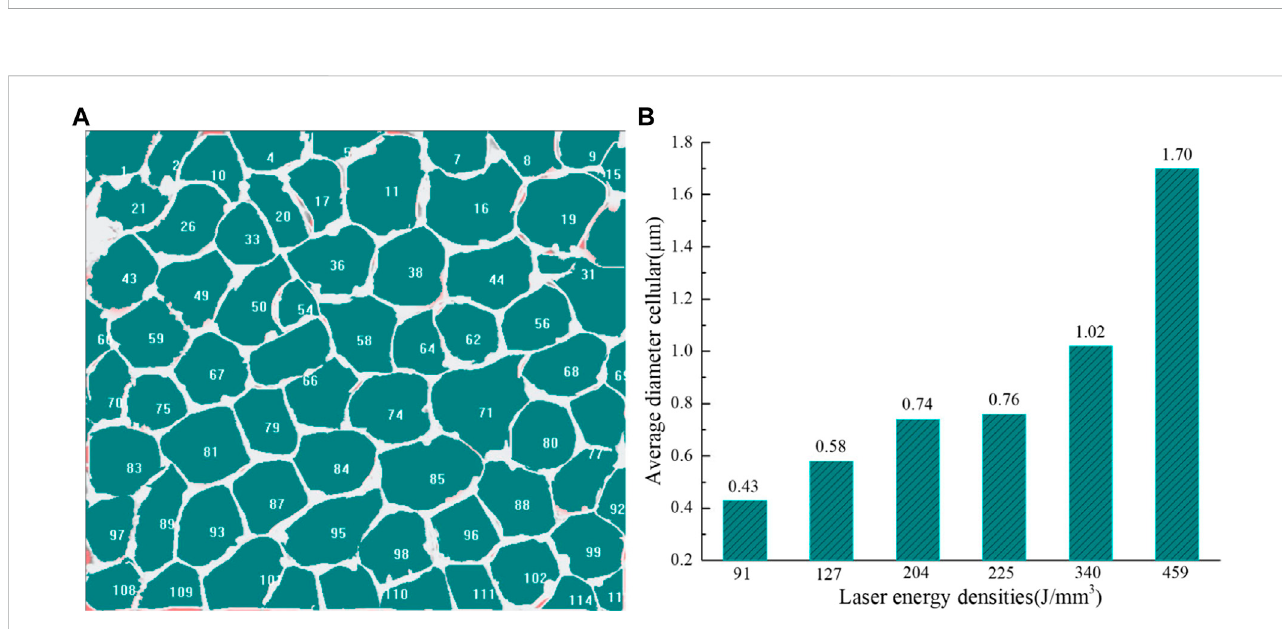
FIGURE 8 The effect of LED on cellular size: (A) P = 180 W, V = 200 mm/s, LED = 459 J/mm 3 , (B) P = 200 W, V = 300 mm/s, LED = 340 J/mm 3 , (C) P = 100 W, V = 200 mm/s,LED=255 J/mm 3 , (D) P=160 W,V=400 mm/s,LED=204 J/mm 3 , (E) P=100 W,V=400 mm/s,LED=127 J/mm 3 , (F) P=160 W,V=900 mm/s, LED = 91 J/mm 3 .